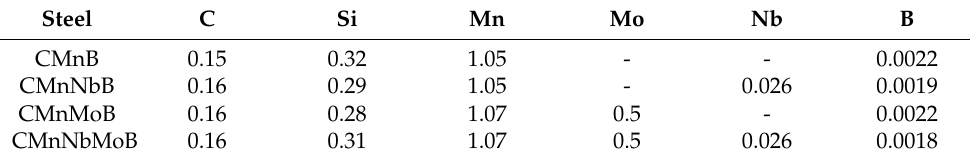
Table 1. Chemical composition of the studied steels (weight percent).